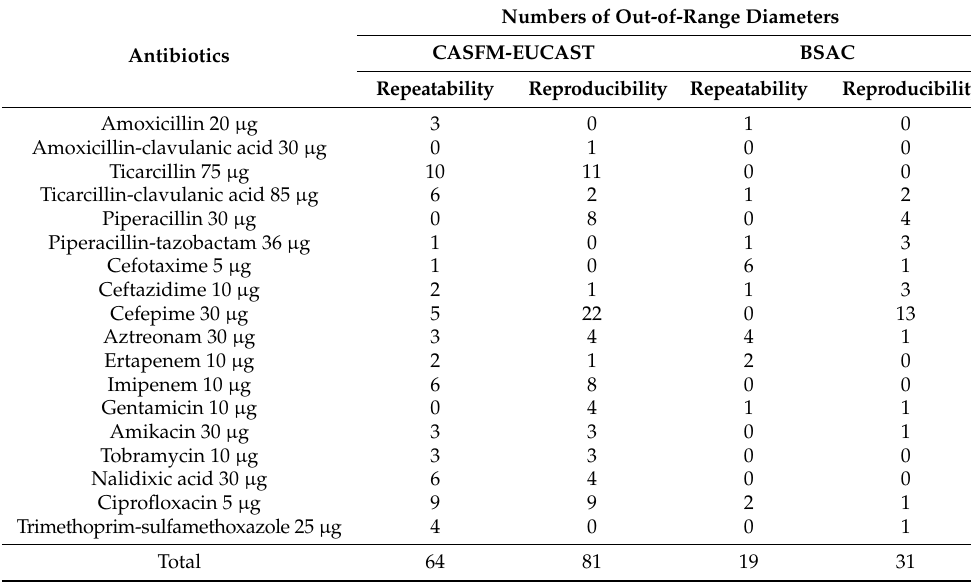
Table 2. Numbers of out-of-range diameters for quality control E. coli strain ATCC 25922 with two MHR-SIR inoculation protocols: CASFM-EUCAST (15 drops of blood in 9 mL NaCl) vs. BSAC (1 drop of blood in 5 mL H 2